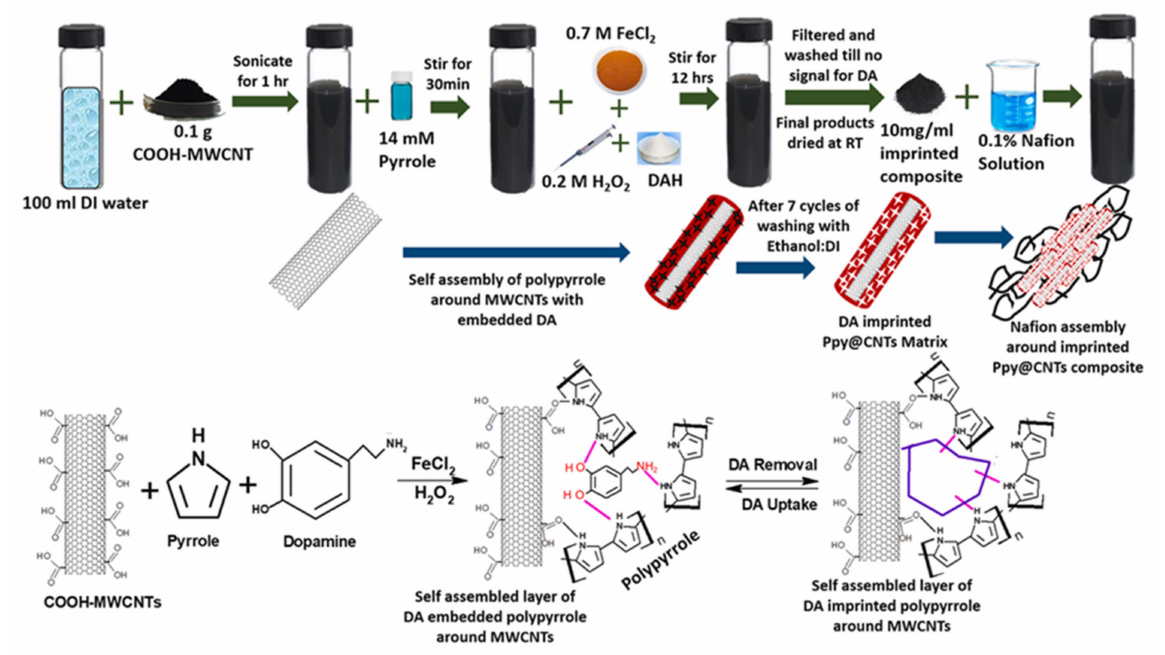
Figure 26. Steps and chemical interactions involved in the preparation of nanocomposite for the fab- rication of SPR based optical fiber DA sensor. Reprinted with permission from Ref. [103]. Copyright 2019